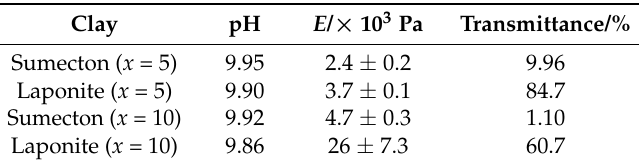
Figure 2. Pictures of 10 wt % sumecton/PAAS blend hydrogel in compression measurements before, during, and after uniaxial compression. Table 1. Characteristic of x wt % clay/PAAS hydrogel.